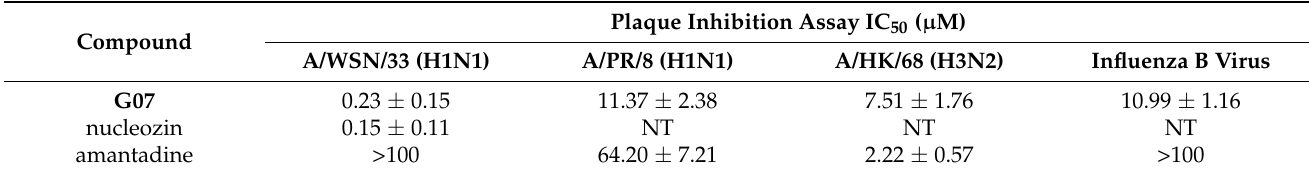
Table 2. The results of compounds in plaque inhibition